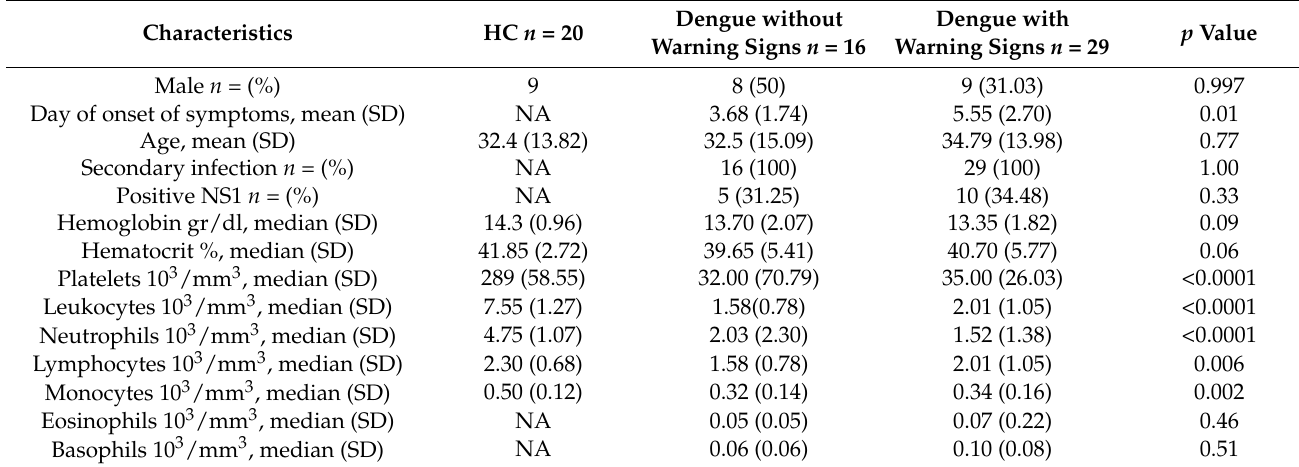
Table 1. Demographic and clinical characteristics of patients and healthy controls.